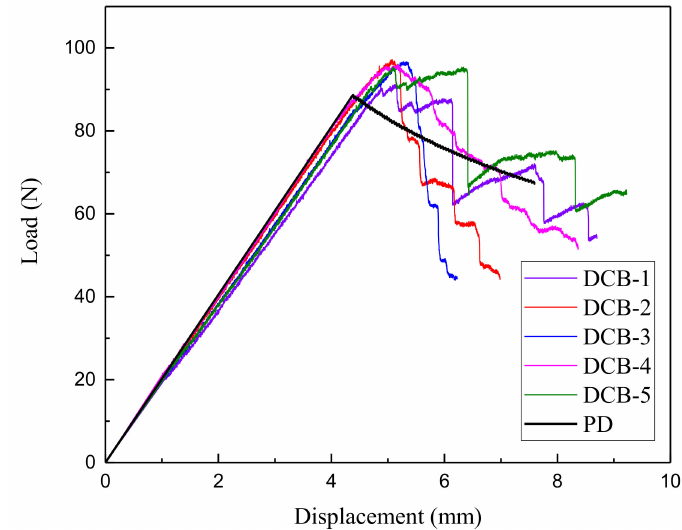
Figure 12. Comparison of load–displacement curve between DCB test and PD (dx = 0.25 mm, dL = 0.008